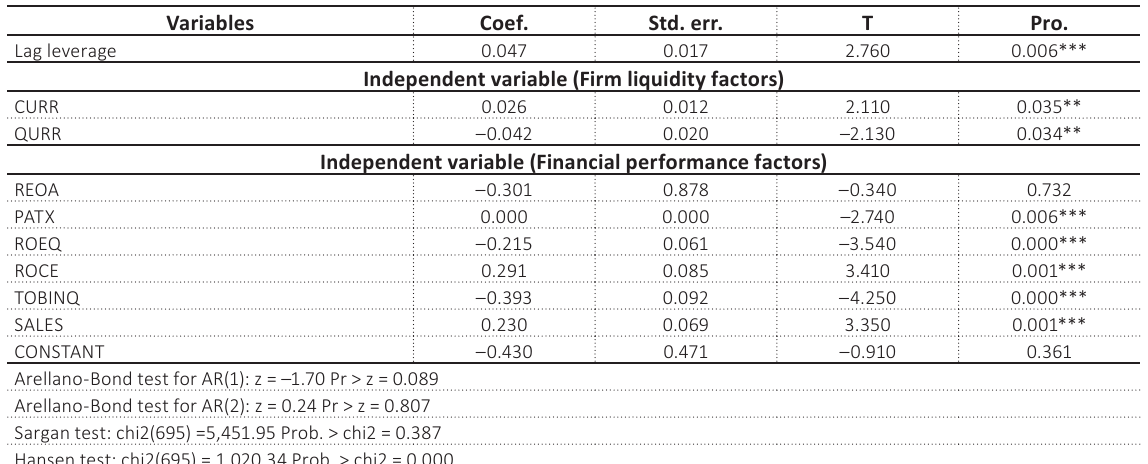
Table 6. GMM estimation